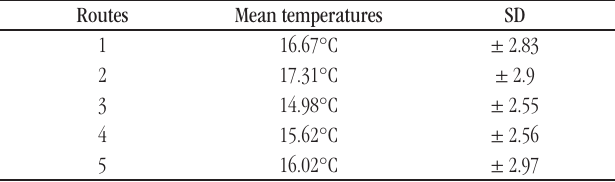
taBLE 3 − Biological materials transported under other temperatures * (10°C-22°C)